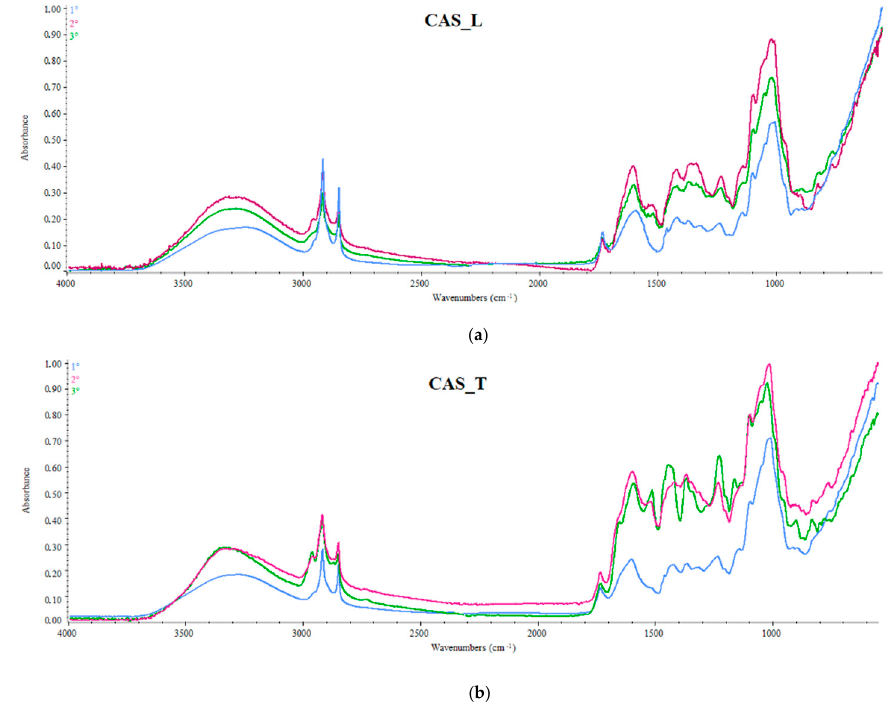
Figure 2. FT-IR raw spectra of hop samples from different growing area, collecting over three consecutive years: blue line: harvest 2016; red line: harvest 2017; green line: harvest 2018. ( a ) CAS_L: Cascade hop samples from Latium; ( b ) CAS_T: Cascade hop samples from Tuscany.